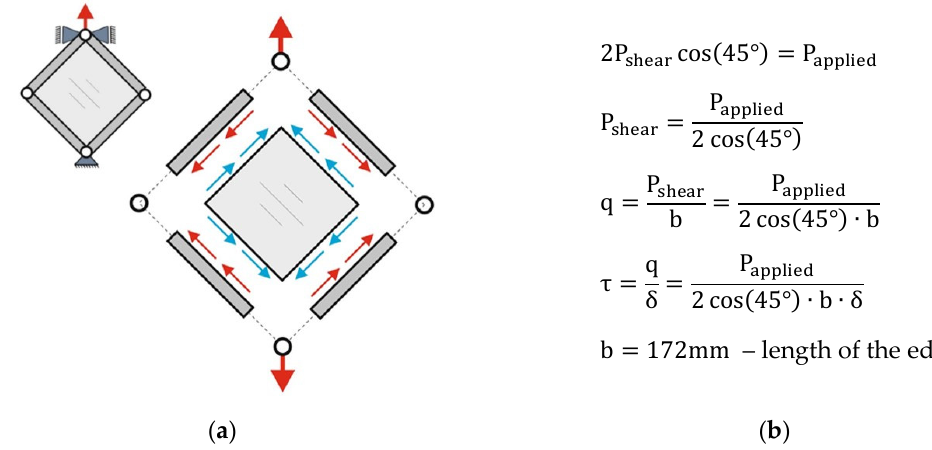
Figure 7. Scheme of the plate load ( a ) and the procedure for determining the tangential stress value ( b